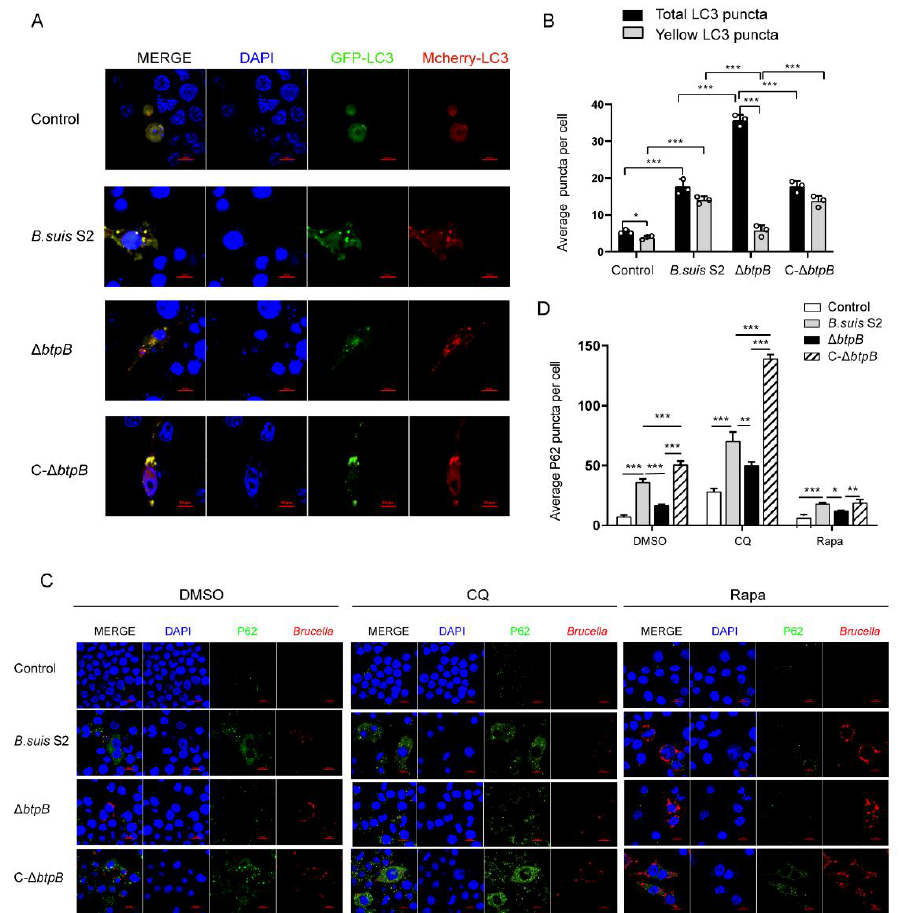
Figure 5. BtpB blocks autophagy flux during Brucella infection. ( A ) Representative confocal images of LC3-GFP and LC3-mcherry puncta. RAW264.7 transfected with mCherry-GFP-LC3 for 24 h, then infected with B. suis S2, Δ btpB , or C- Δ btpB (MOI = 200) for 12 and 24 h. Scale bars, 10 μm. ( B ) The average number of LC3 puncta per cell in RAW264.7. ( C ) RAW264.7 cells were infected with Brucella strains (MOI = 200) for 24 h and treated with or without 10 μM chloroquine or 10 nM rapamycin. P62 puncta were detected b y confocal immunofluorescence microscopy. Scale bars, 10 μm. ( D ) The average number of P62 puncta per cell in RAW264.7. The experiment was repeated three times, and data represent mean ± SD. Two- tailed Student’s t -test was used for comparison between two groups. One-way ANOVA and post-hoc Bonferroni multiple comparison test were used to compare more than two groups. * p < 0.05; ** p < 0.01; *** p < 0.001. 2.6. Autophagy Inhibition Decreases Brucella Replication To analyze the role of autophagy in Brucella replication and the effect of BtpB on the intracellular survival of B. suis S2, we examined the intracellular viability of Brucella strains following chloroquine treatment. As shown in Figure 6, chloroquine significantly decreased Brucella CFU counts in RAW264.7 cells after 24 and 72 h. Chloroquine also re- duced the intracellular survival of the Δ btpB mutant after 12 h and significantly decreased CFU number at 24 hpi, compared to B. suis S2 and C- Δ btpB .